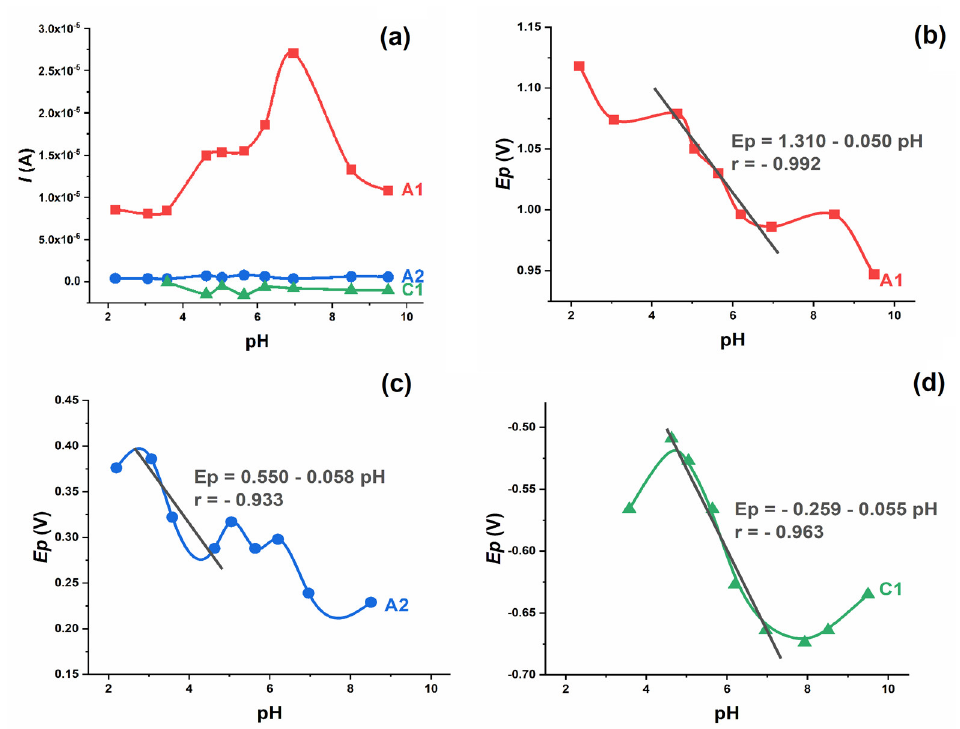
Figure 2. The influence of pH on the 0.2 mmol L − 1 IVM CV peak current and potential. Plot of I p vs. pH ■ —peak A1, ●—peak A2, ▲ —peak C1 ( a ). Plot of E p vs. pH for peak A1 ( b ), peak A2 ( c ) and peak C1 ( d ).